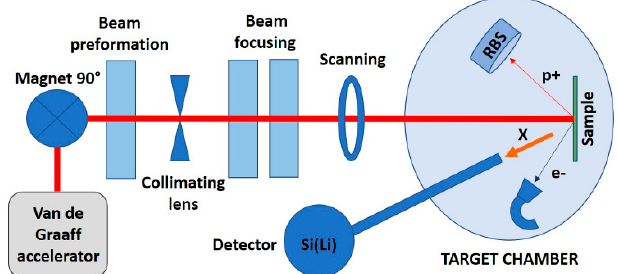
Figure 3. Experimental setup of the Cracow’s scanning nuclear microprobe providing source for proton beam for sample irradiation.